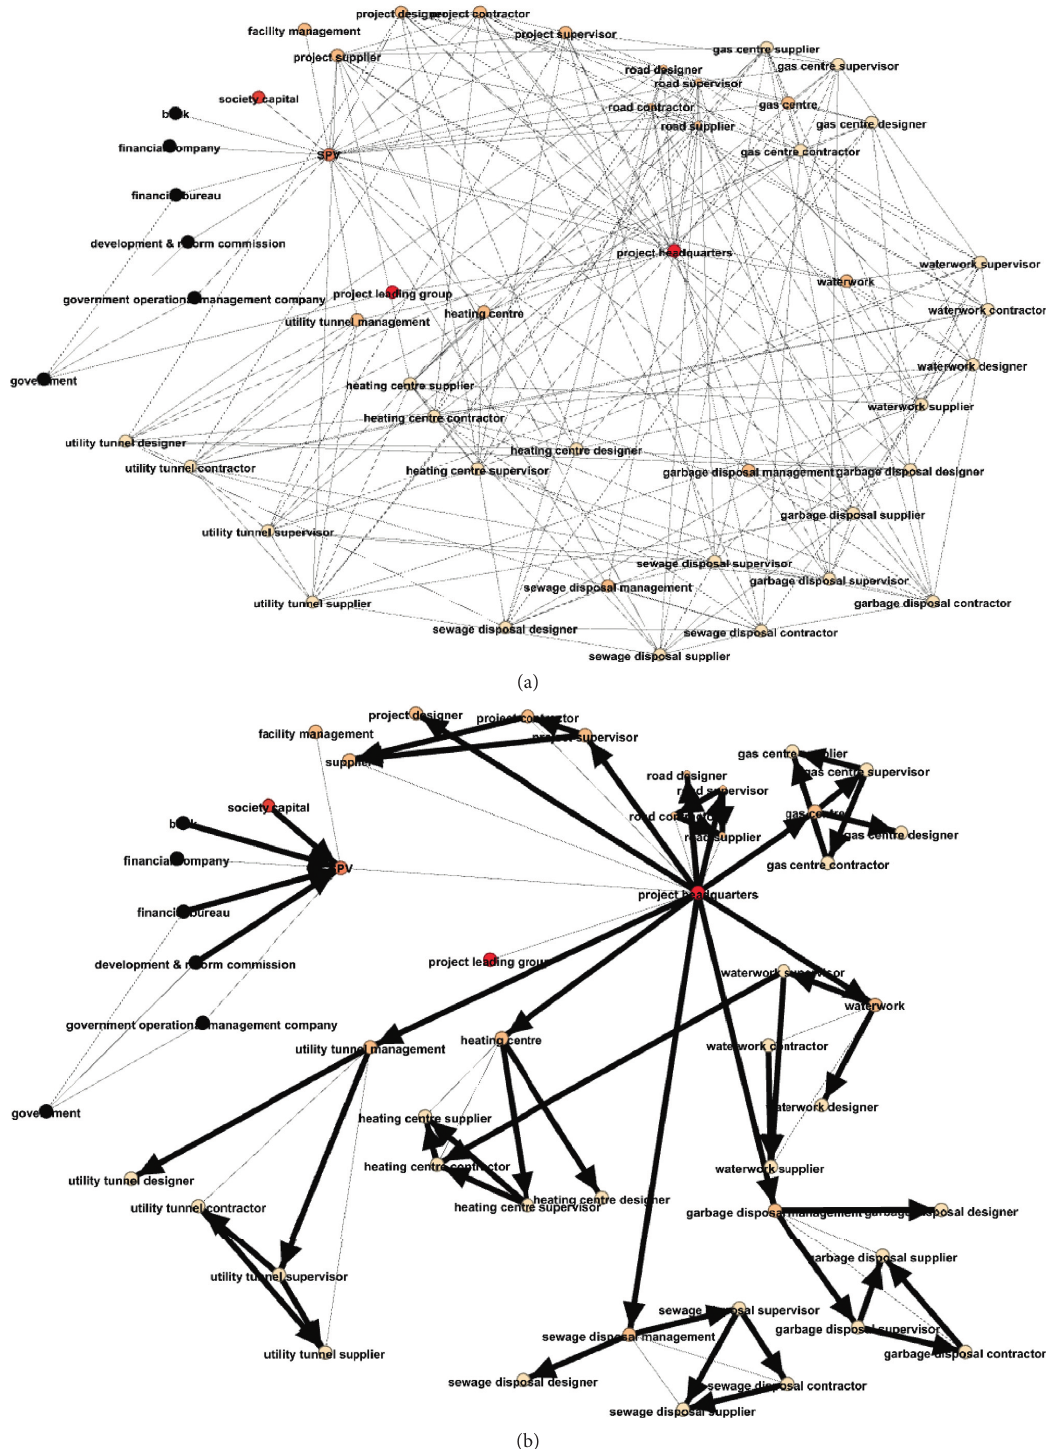
Figure 1: Relationships of project network diagram. (a) CCN diagram. (b) SRN